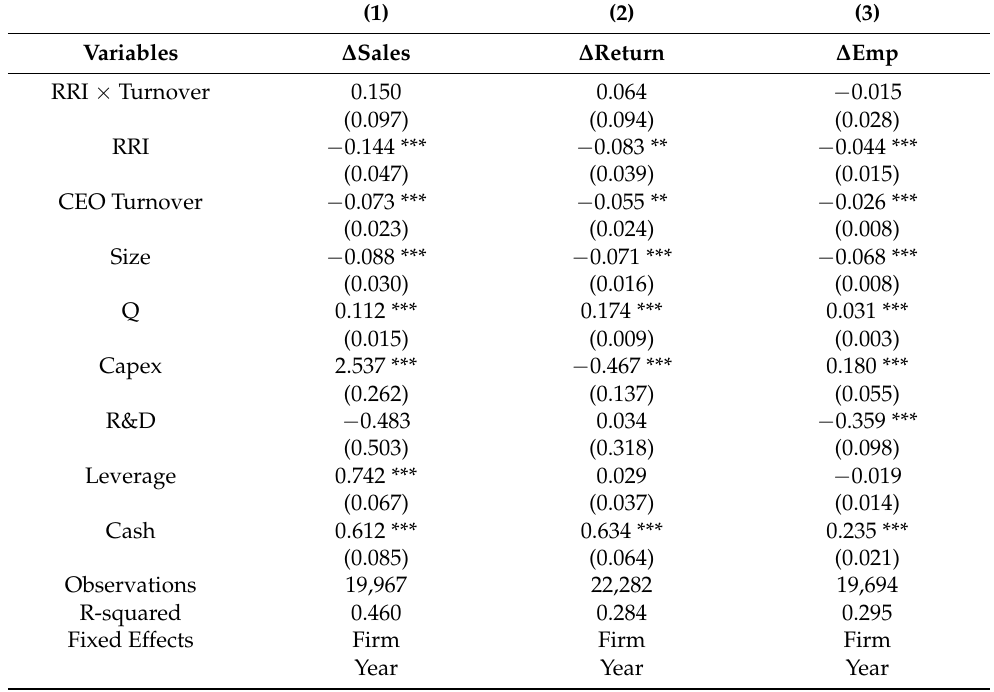
Table 7. Does turnover mitigate the negative effects of RRI? The dependent variable for column (1) is sales growth, (2) is stock returns and (3) is employment growth. See the Appendix A for variable definitions. Standard errors are clustered by firm and reported in parentheses. *, ** and *** represent statistical significance at the 10%, 5% and 1% level,